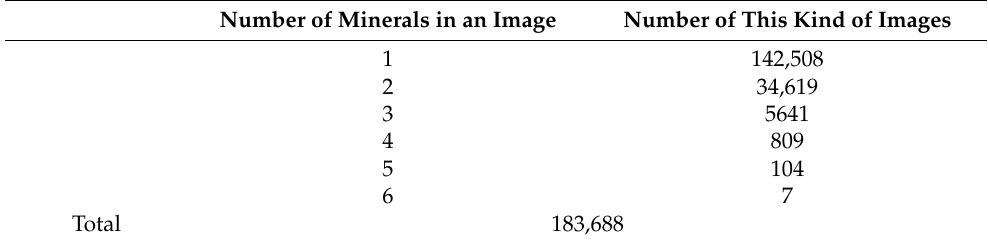
Table 1. Number of minerals in an image and the number of this kind of images. Number of Minerals in an Image